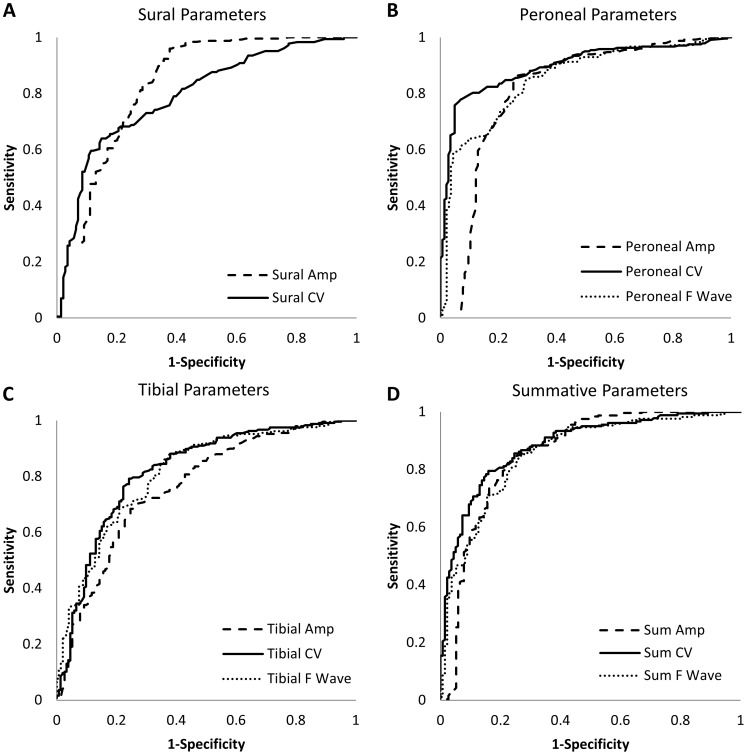
Concurrent validity ROC curves for sural, peroneal, tibial and summative parameters.See Table 2 for estimates of AROC for each parameter. Peroneal conduction velocity and sural amplitude potential had the highest AROC (AROC 0.90 and 0.83, respectively). Dashed lines represent amplitude potentials. Solid lines represent conduction velocities. Dotted lines represent F-wave latencies.